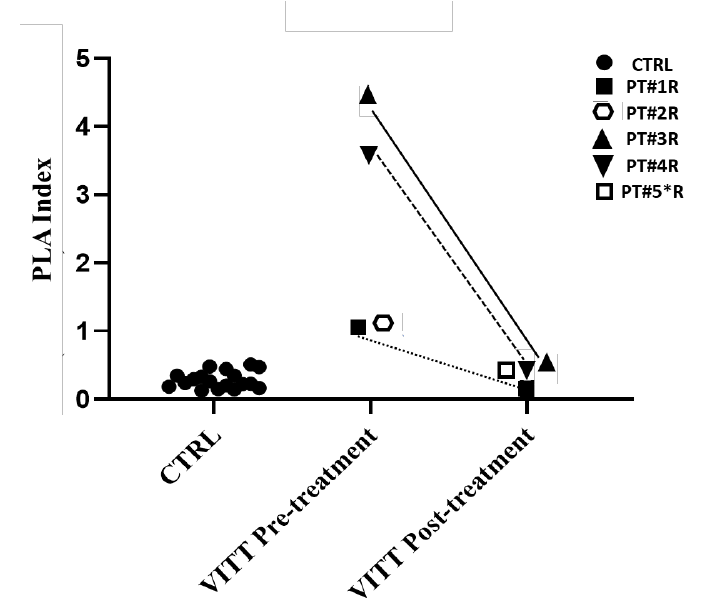
Figure 2. HEPLA index in 5 VITT patients compared to controls, i.e., no-VITT patients investigated for thrombosis or thrombocytopenia after Vaxzevria (AstraZeneca) and Ad26.COV2.S (Johnson & Johnson) ( n = 18). PT#2R was investigated before death occurred after 12 h. PT#5R* was investigated 24 h after IvIg therapy had been started. * Patients analyzed under IvIg therapy.